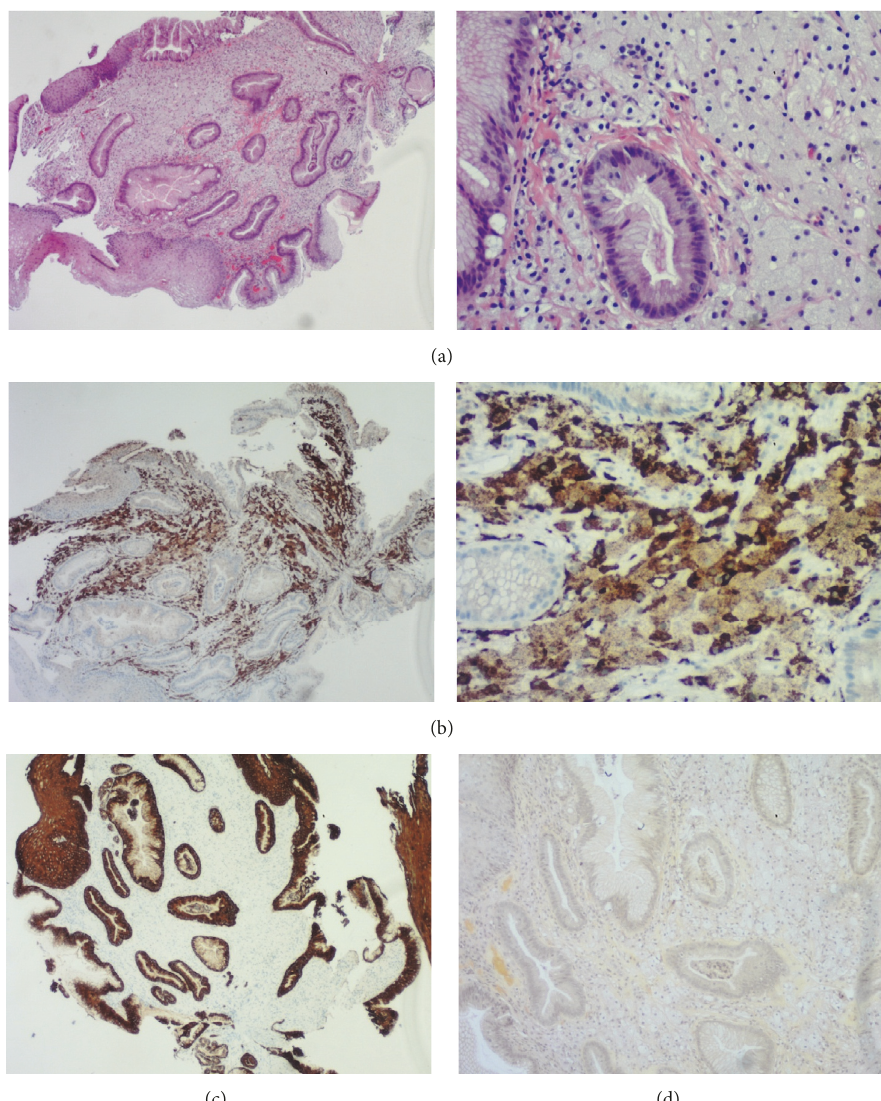
Figure 2: (a) Squamous and gastric mucosa with foamy histiocytes in the lamina propria (low and high power). (b) CD68 stain (low and high power) staining histiocytes brown in lamina propria. (c) A negative AE1/AE3 stain ruling out an epithelial lesion (carcinoma) as shown by staining the epithelium but the histiocytes in the lamina propria were negative. (d) A negative mucicarmine special stain ruling out signet ring cell